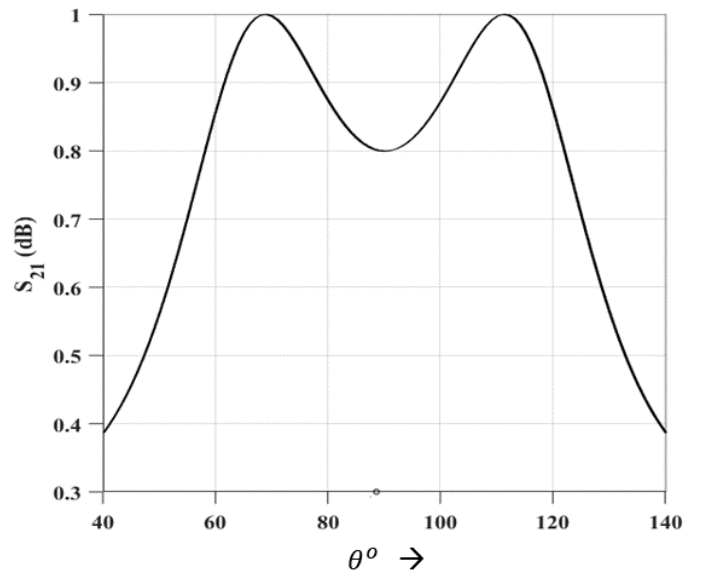
Figure 3. Transfer characteristics of the proposed network. The transmission characteristics S 21 of the Chebyshev function in (11) is plotted as function of θ and θ c in Figure 4. It is noted that at θ = 90 ◦ , the filter has band-pass characteristics with a change in bandwidth for different values of θ c .